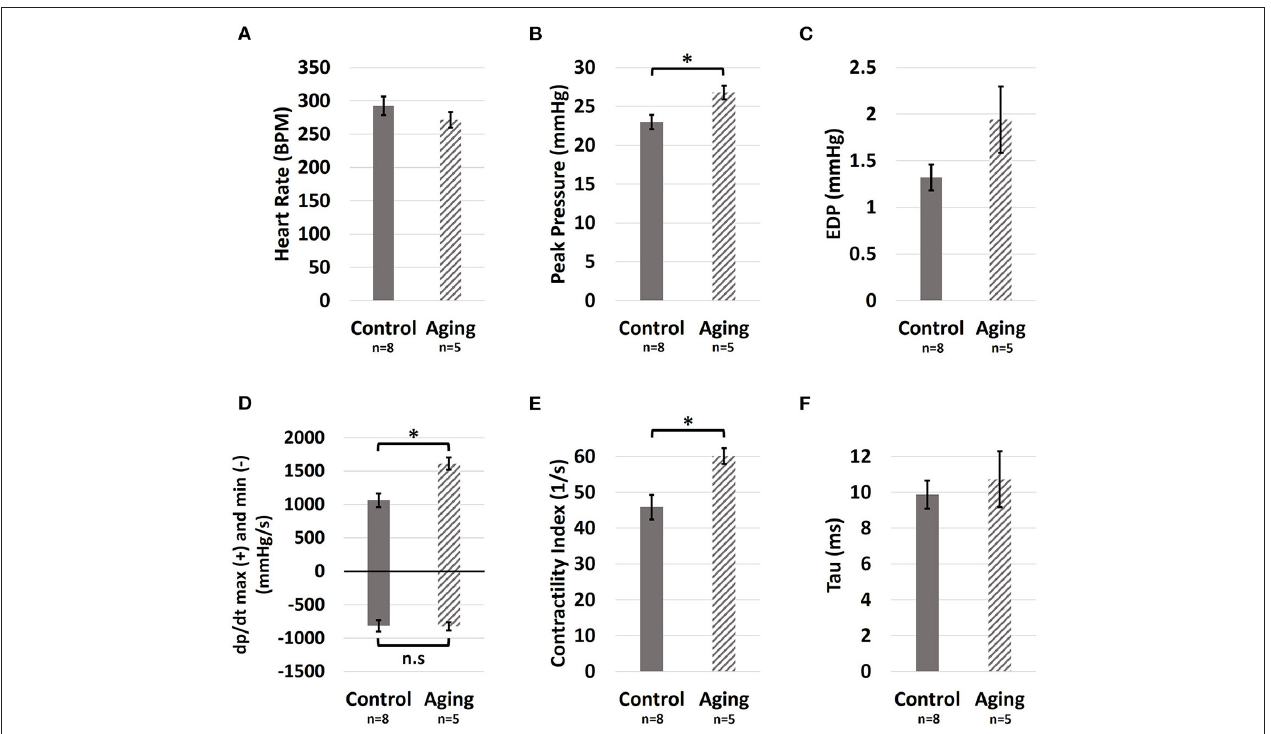
FIGURE 2 | Hemodynamic measures of the effects of healthy aging on RV (A) Heart rate, (B) Peak pressure, (C) End-diastolic pressure, (D) dp dp min (negative side), (E) Contractility index, and (F) The preload-independent measure of relaxation (tau). Healthy aging significantly increased RV peak pressures dt and the load-dependent measures of RV contractility ( dp max and contractility index), while not affecting the heart rate, end-diastolic pressures (EDP), and relaxation dt function ( dp min and tau). Error bars represent standard error of the mean (SEM). *Indicates p < 0.05. RV, Right ventricle; BPM, Beats per minute; EDP, End-diastolic dt pressure; dp max and min, Load-dependent measures of RV contractility and relaxation; n.s, dt